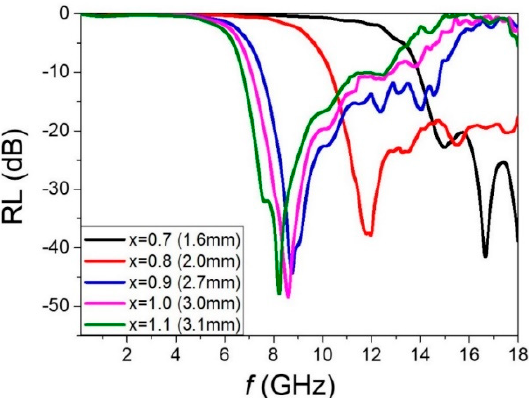
Figure 8. RL vs. f plot of SrFe 12 − 2x Zn x Zr x O 19 ( x = 0.7, 0.8, 0.9, 1.0, 1.1) powder–epoxy composites for determining optimal absorber thickness (mm).